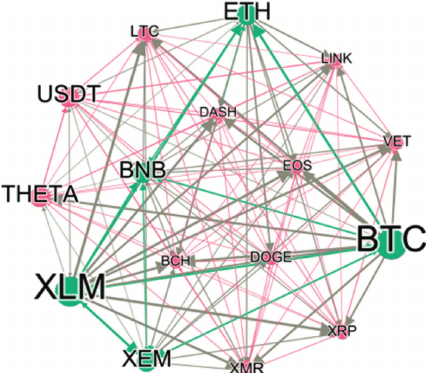
Figure 26: Risk spillover under D1.